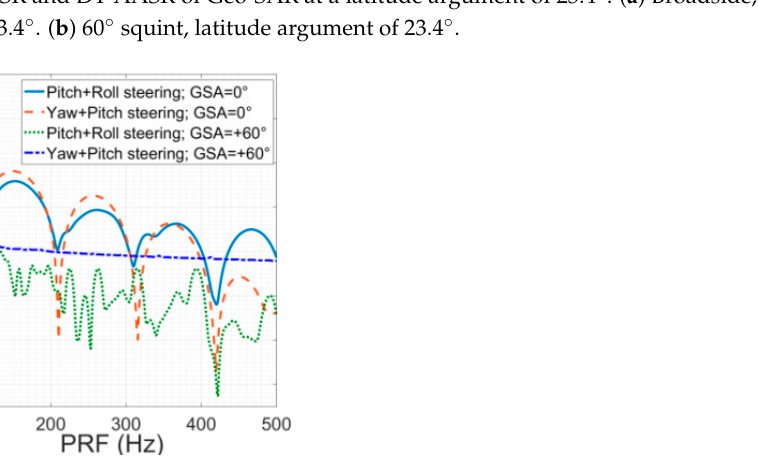
Figure 14. AASR and DT-AASR of Geo-SAR at a latitude argument of 23.4°. ( a ) Broadside, latitude argument of 23.4°. ( b ) 60° squint, latitude argument of 23.4°.